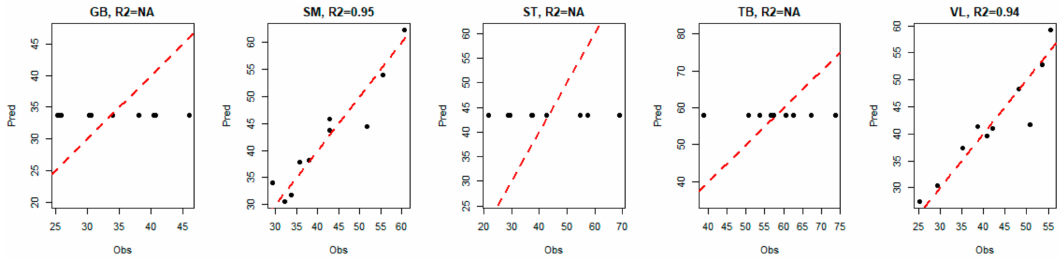
Figure 7. Evolution of predicted tenderness according to observed tenderness in each